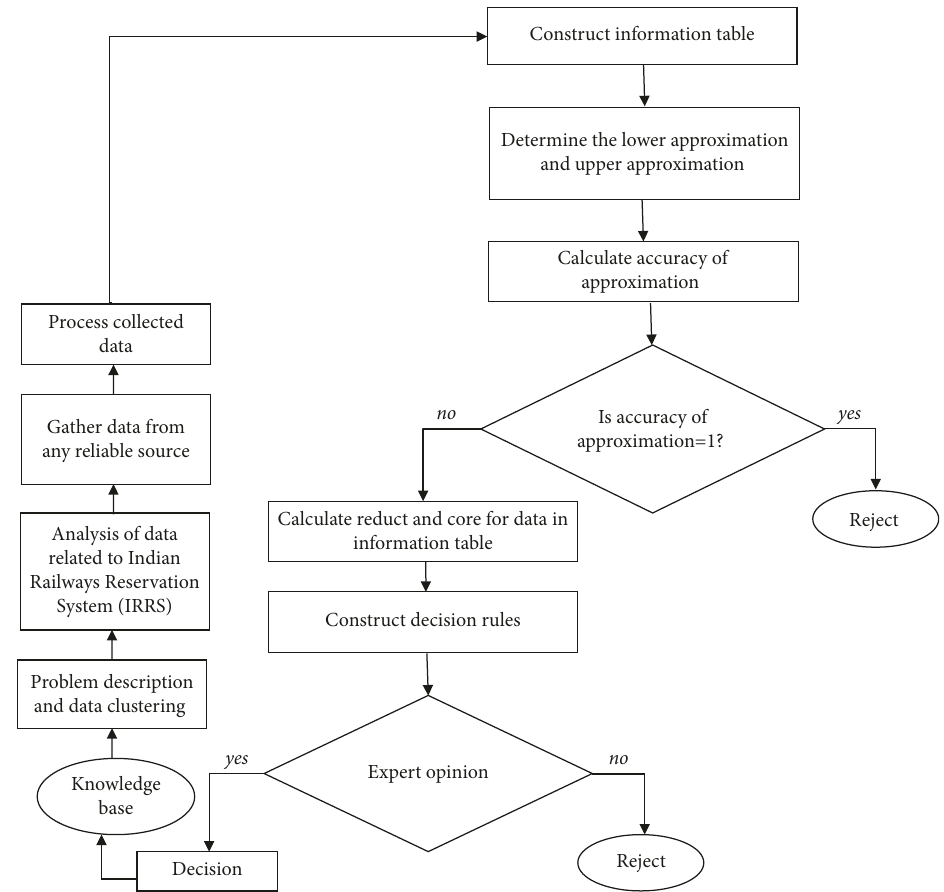
Figure 2: Analysis structure of the RST approach for the